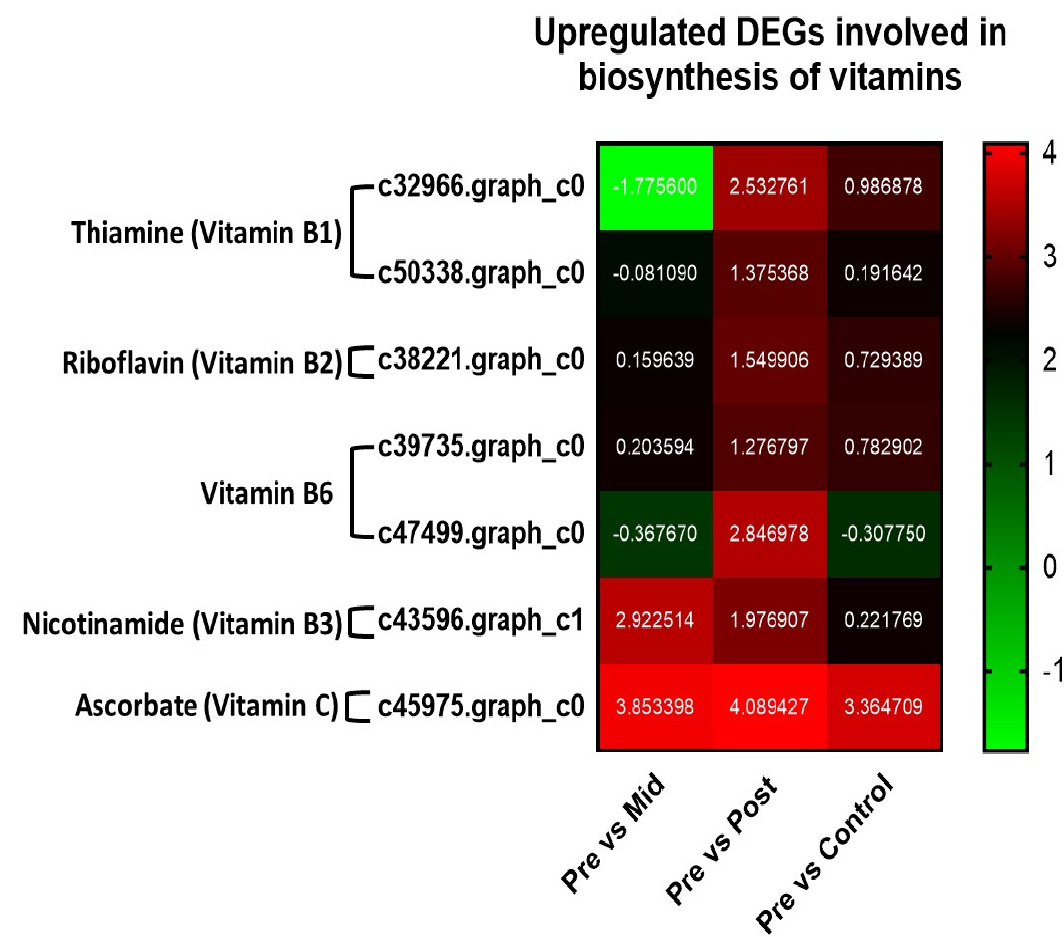
Figure 4. Heat map of upregulated DEGs involved in vitamin biosynthetic pathways in water dropwort under mid − blanched, post − blanched, and control conditions.